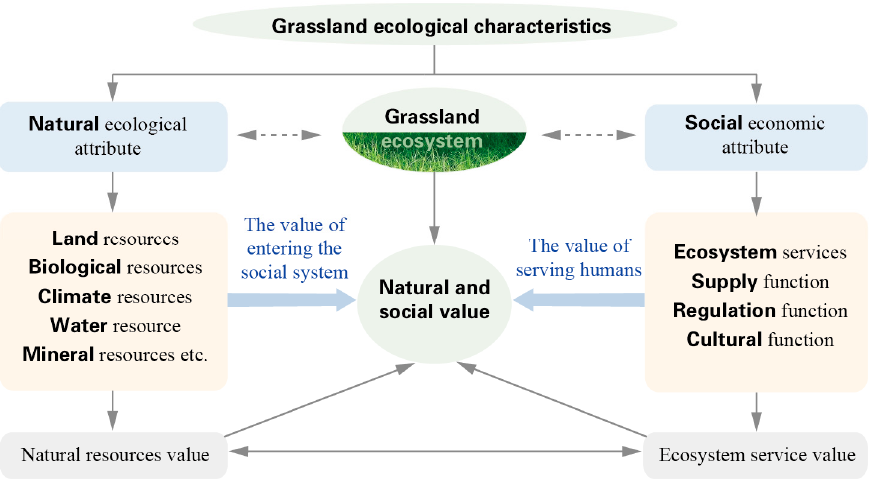
Figure 9. Future research themes and directions of grassland ecosystems.